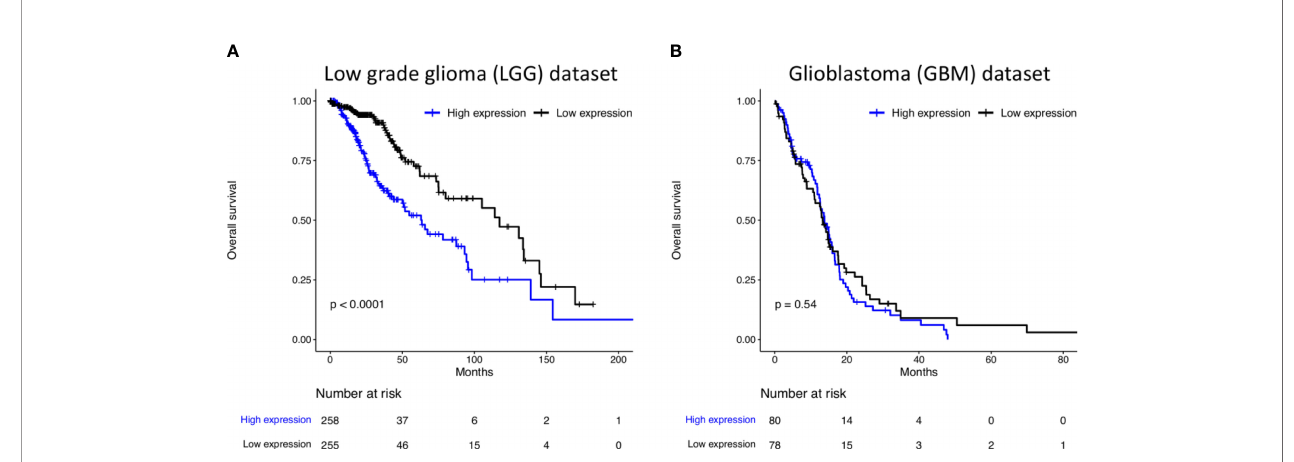
FIGURE 2 | Kaplan – Meier curves of survival related to ITGA2 in (A) 515 patients LGG. LGG patients with high expression of ITGA2 had a poorer overall survival compared with patients with low expression and (B) 159 patients with GBM. The expression of ITGA2 in GBM was not statistically signi fi cant when compared with patients with low and high expressions and overall